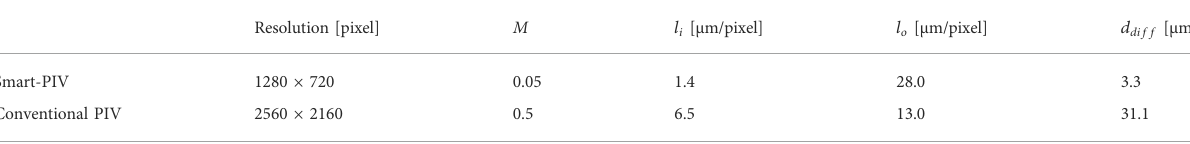
TABLE 3 Imaging parameters of smart and conventional PIV: resolution, magni fi cation factor ( M ), pixel size in the image plane ( l i ), pixel size in the object plane ( l o ), diffraction limited image diameter ( d diff ). Resolution [pixel]